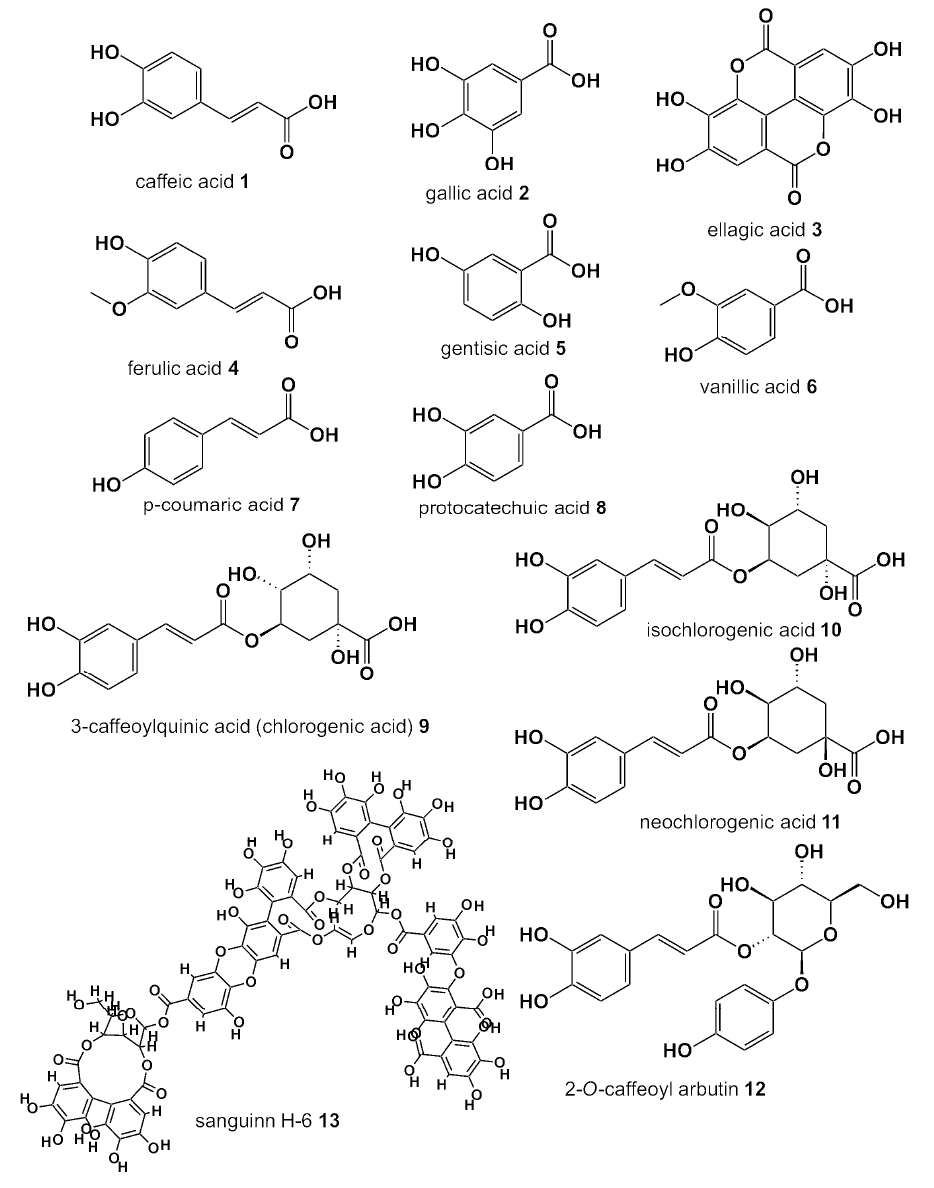
Figure 2 : Structures of the most common phenolic acids and acid derivatives of berry leaves. Figure 2. Structures of the most common phenolic acids and acid derivatives of berry